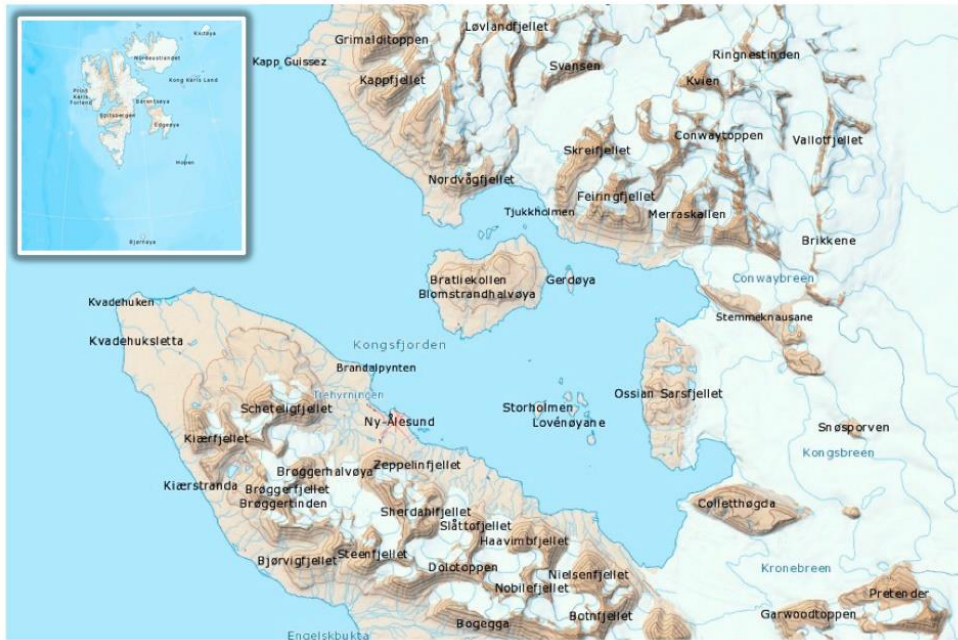
Figure 1. Map of Svalbard (Norway) and Kongsfjorden (Norsk Polar Institute).